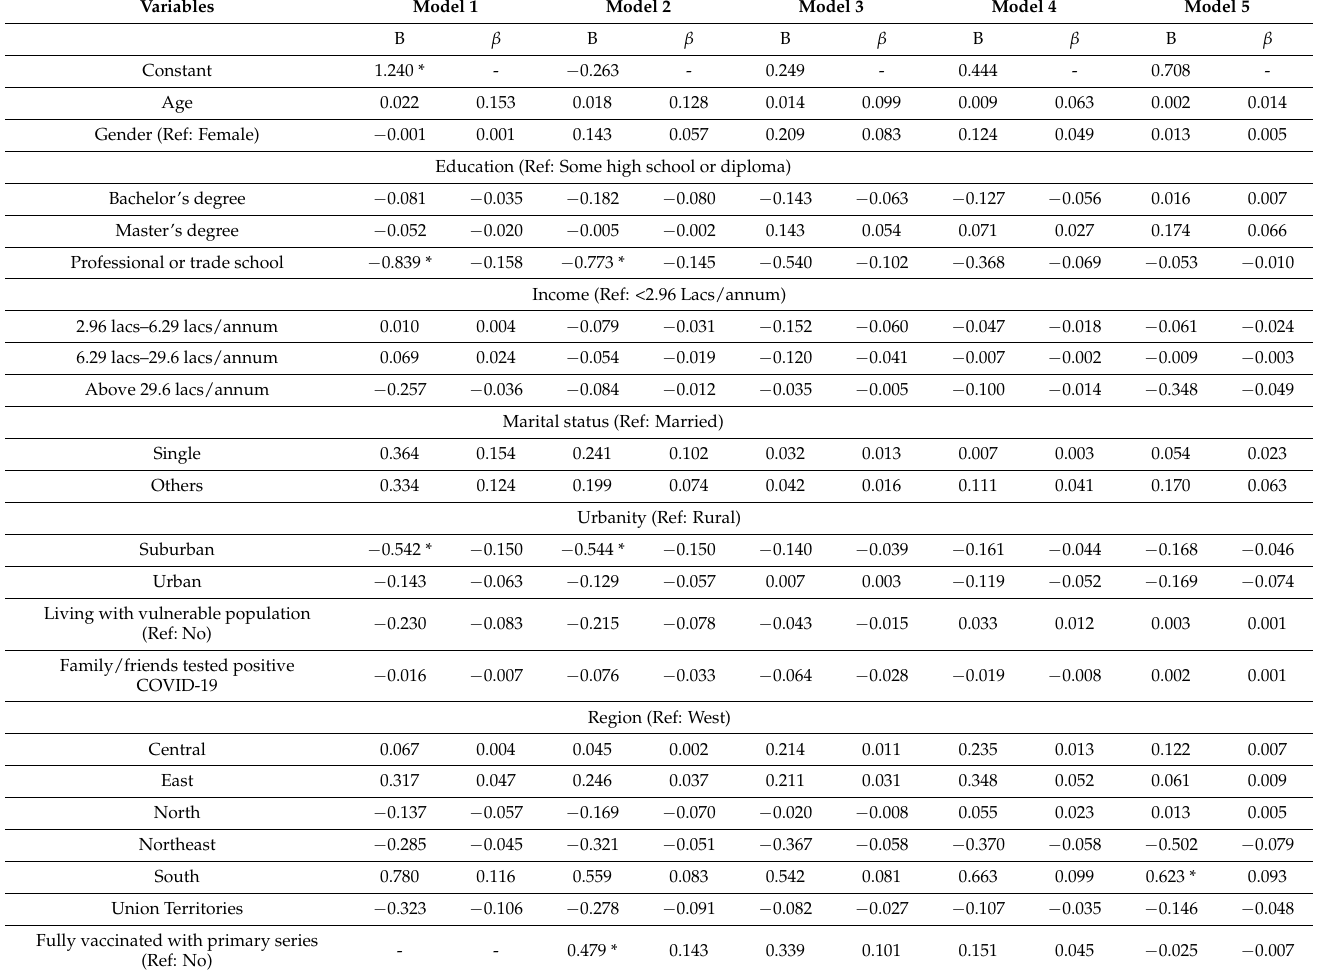
Table 5. Hierarchical Multiple Regression (HRM) predicting intention of COVID-19 booster dose initiation among hesitant respondents ( n =